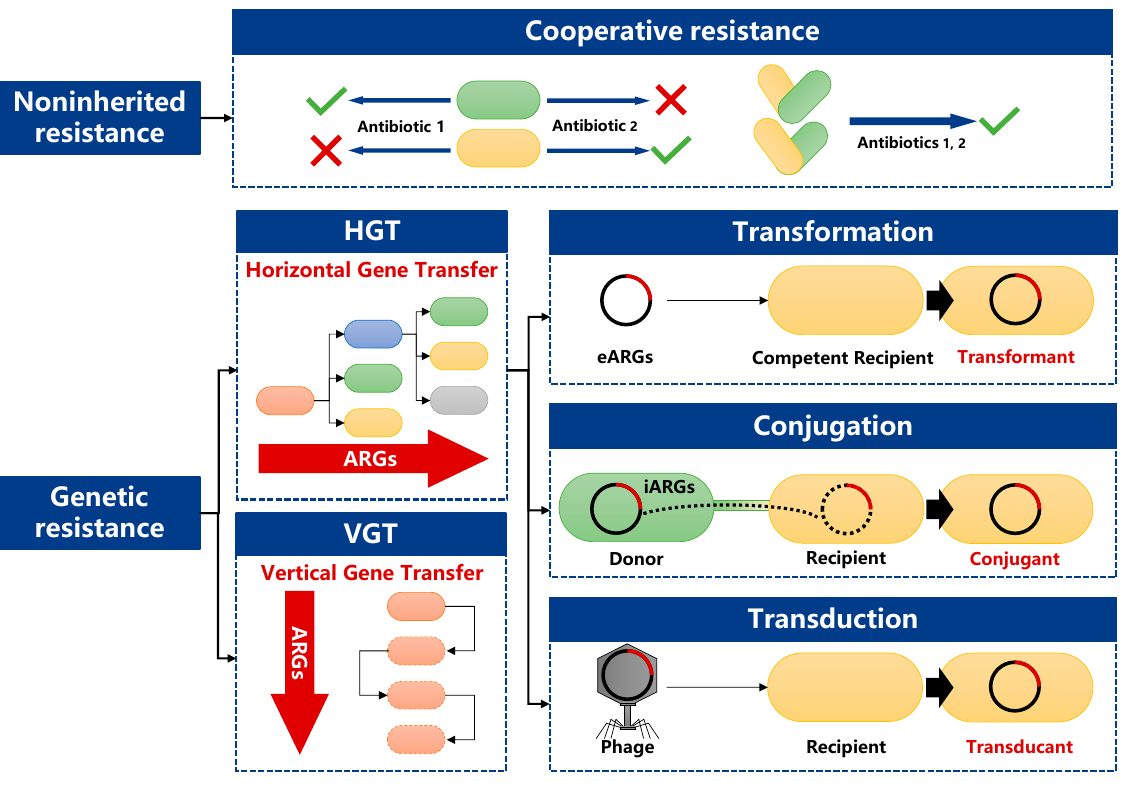
Figure 1. Transmission routes of antibiotic resistance genes (ARGs: antibiotic resistance genes, eARGs: extracellular ARGs, iARGs: intracellular